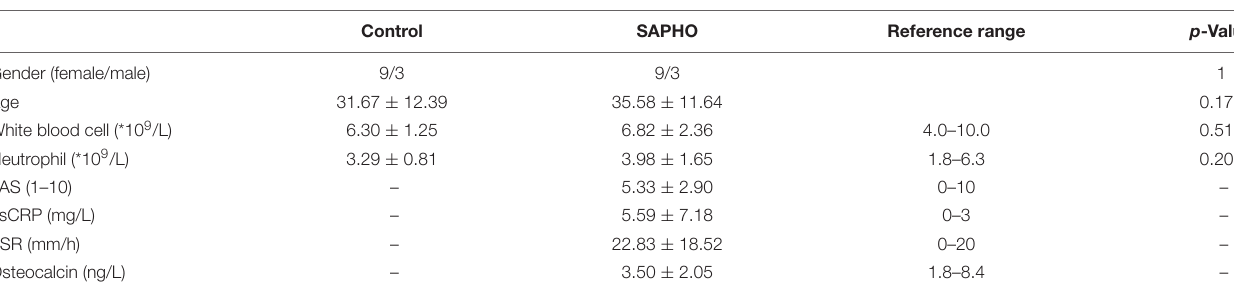
TABLE 2 | Features of included